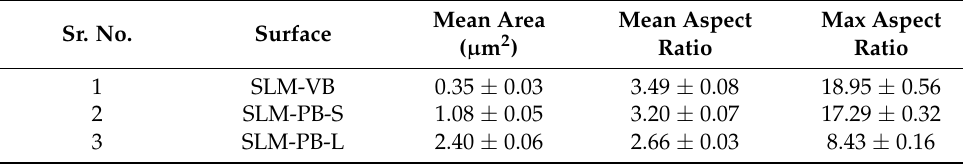
Table 3. Grain geometry information of SLM Ti6Al4V samples. Sr.